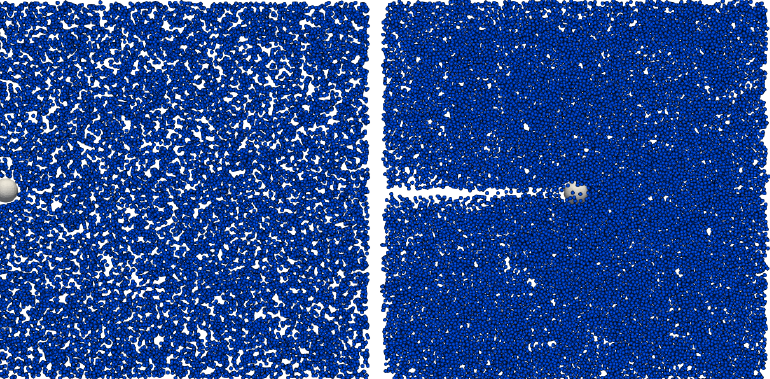
Figure 3. Initial position of a sphere in a drag force computational experiment ( left ). A horizontal force F drag is applied to the sphere, eventually resulting in a steady terminal velocity ( right ). To visu- alise the cell movement in the suspension, only a slice (width ± 1 µ m from the central x − y plane of the channel) of the suspensions is rendered. Size of the channel 96 × 96 × 96 µ m 3 , cell radius R = 3 µ m.